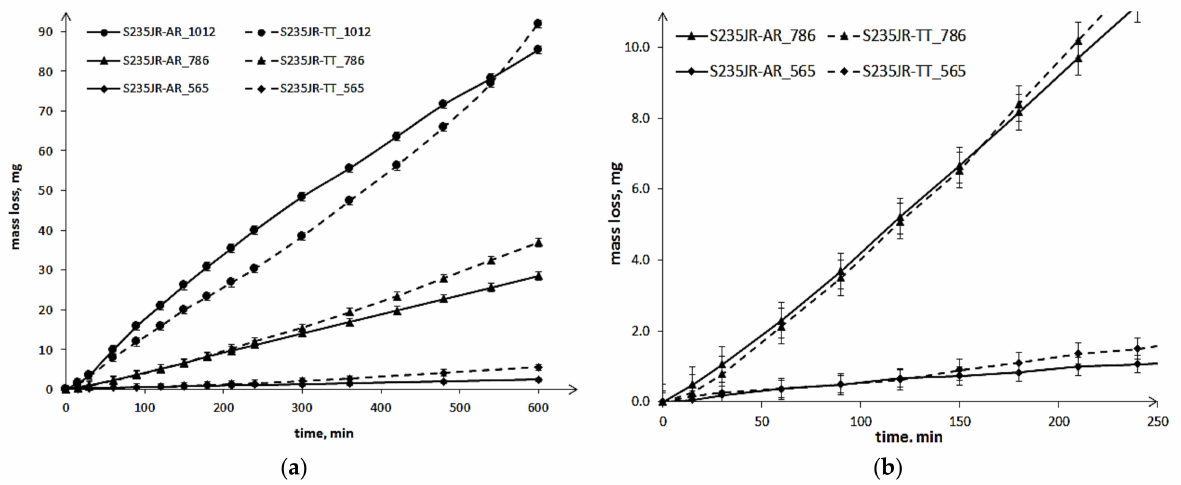
Figure 8. Slurry erosion curves of S235JR-AR and S235JR-TT steels: ( a ) full test duration, ( b ) initial 250 min of testing steels at 786 and 565 rpm.